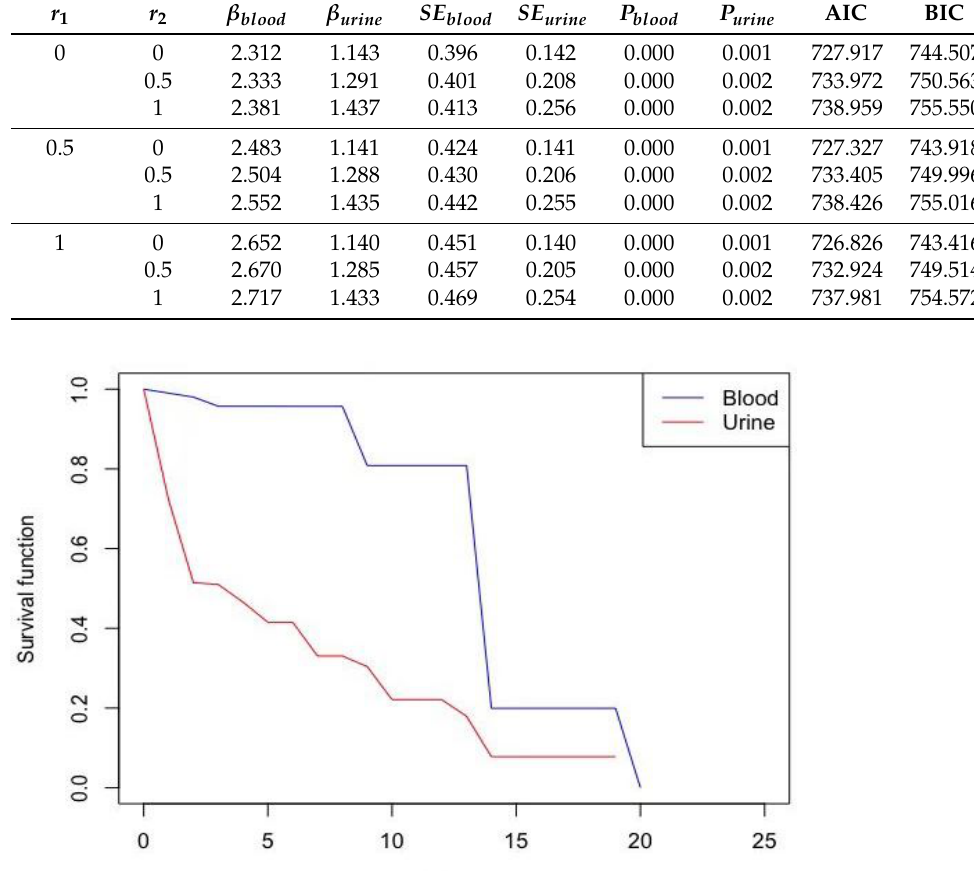
Table 5. Analysis results for the AIDS clinical trials data.